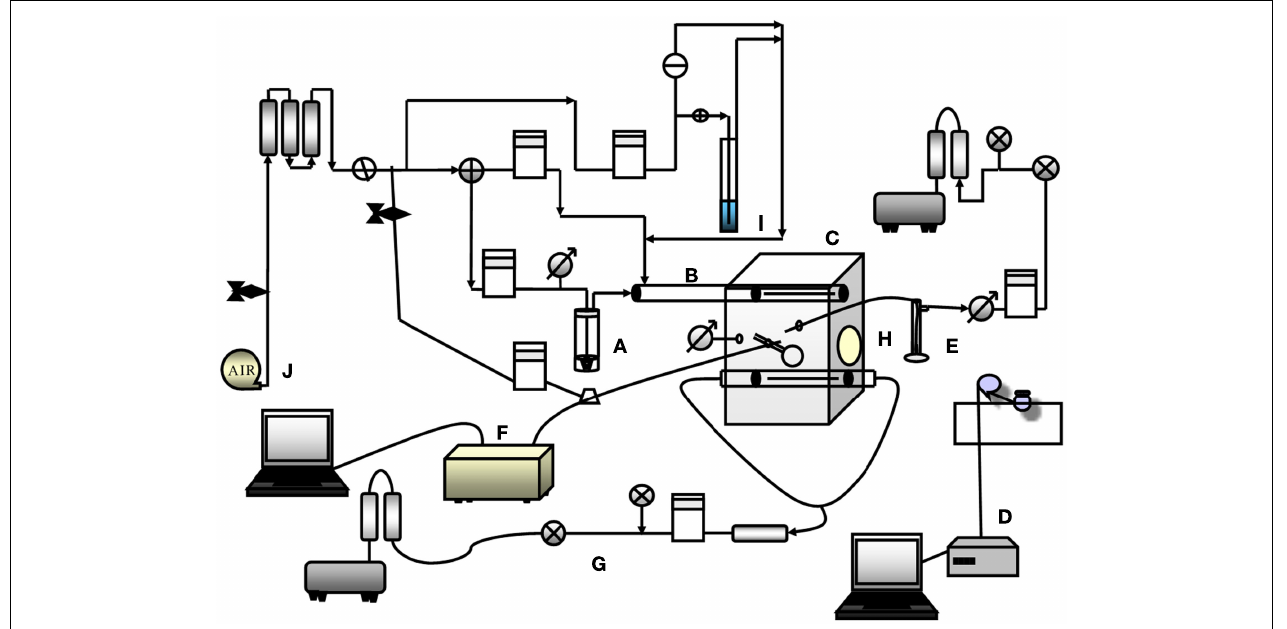
FIGURE 1 | Diagram of the inhalation exposure system used throughout the testing. Diagram shows all subsystems. A is the aerosol generator, Collison nebulizer, B is the delivery and mixing tube, C is the exposure chamber along with ports for the animal muzzle temperature and humidity